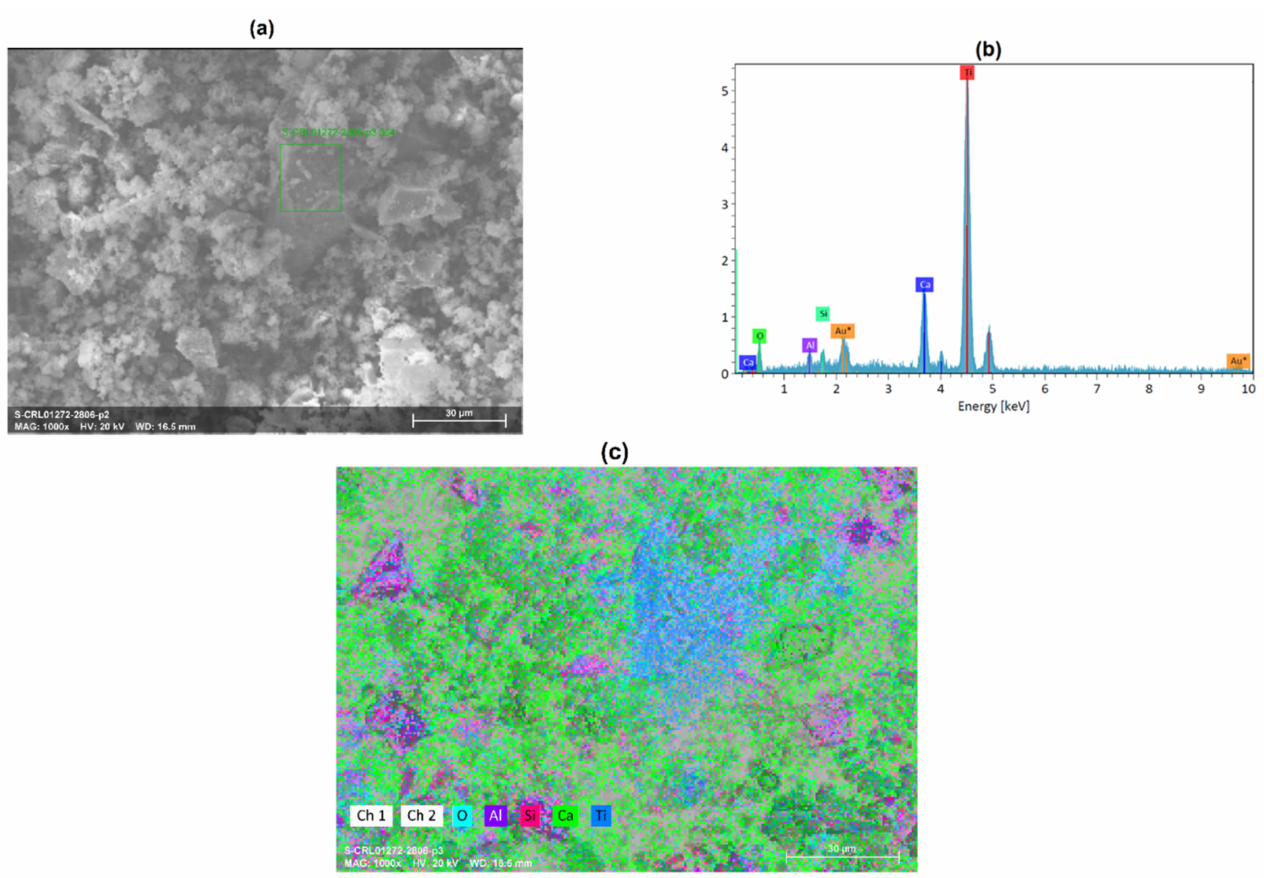
Figure 5. ( a ) SEM micrograph of bauxite-embedded TiH 2 , ( b ) EDX analysis of green square in ( a ), and ( c ) color map of elements in ( a ).